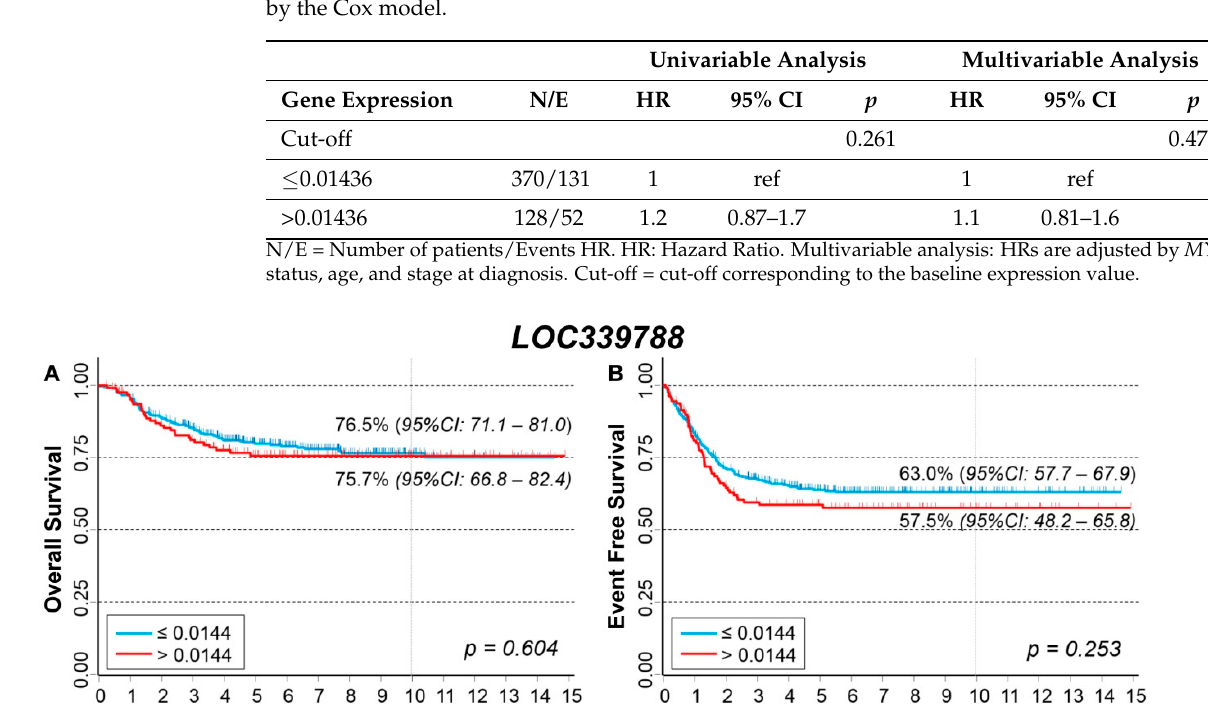
Table 16. Event Free Survival of 498 NB patients in relation to LOC339788 expression levels evaluated by the Cox model.